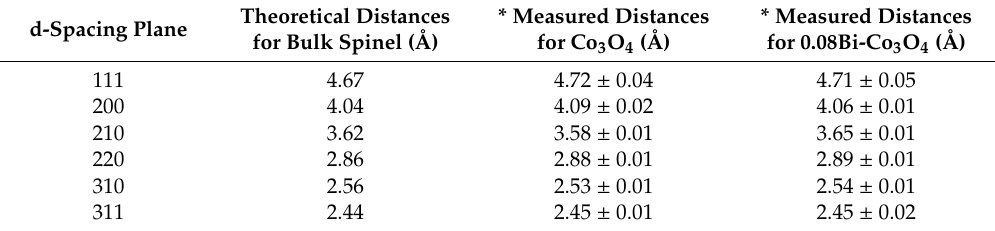
Table 2. Comparison of the theoretical and experimental distances of the selected lattice planes ((111), (200), (210), (220), (310), and (311)) in the bare (Co 3 O 4 ) and doped (6.6 wt % Bi-Co 3 O 4 ) catalytic nanocrystals.